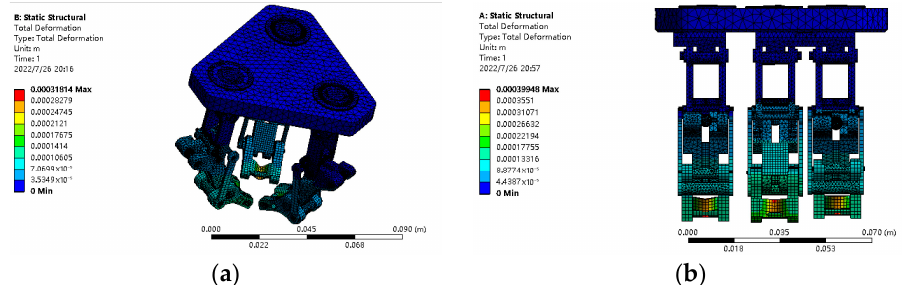
Figure 12. Finite element analysis results of gripper. ( a ) Three-finger symmetrical grasp; ( b ) Three- finger parallel grasp.